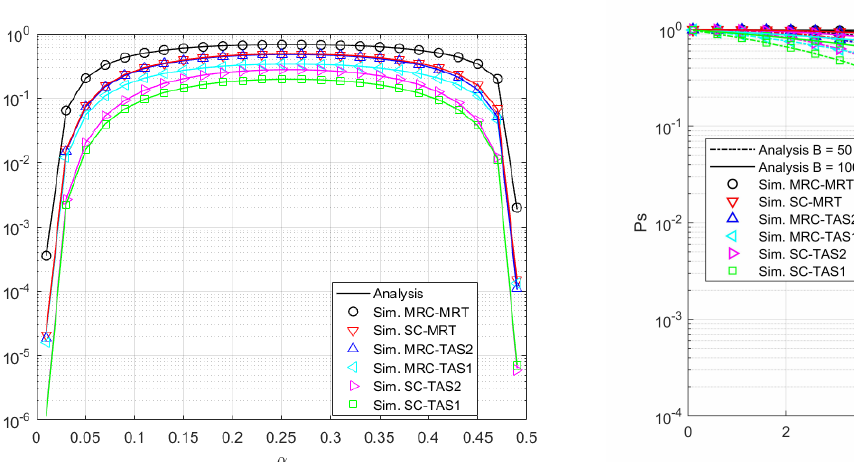
Figure 12. Impacts of the length of task and the bandwidth of antennas and by selecting the optimal set of key parameters: data offloading ratio, time switching ratio, and power allocation